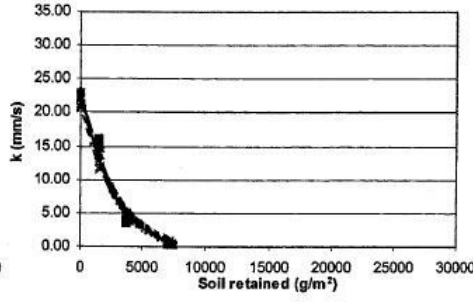
Figure 15: Content of soil retained vs. permeability